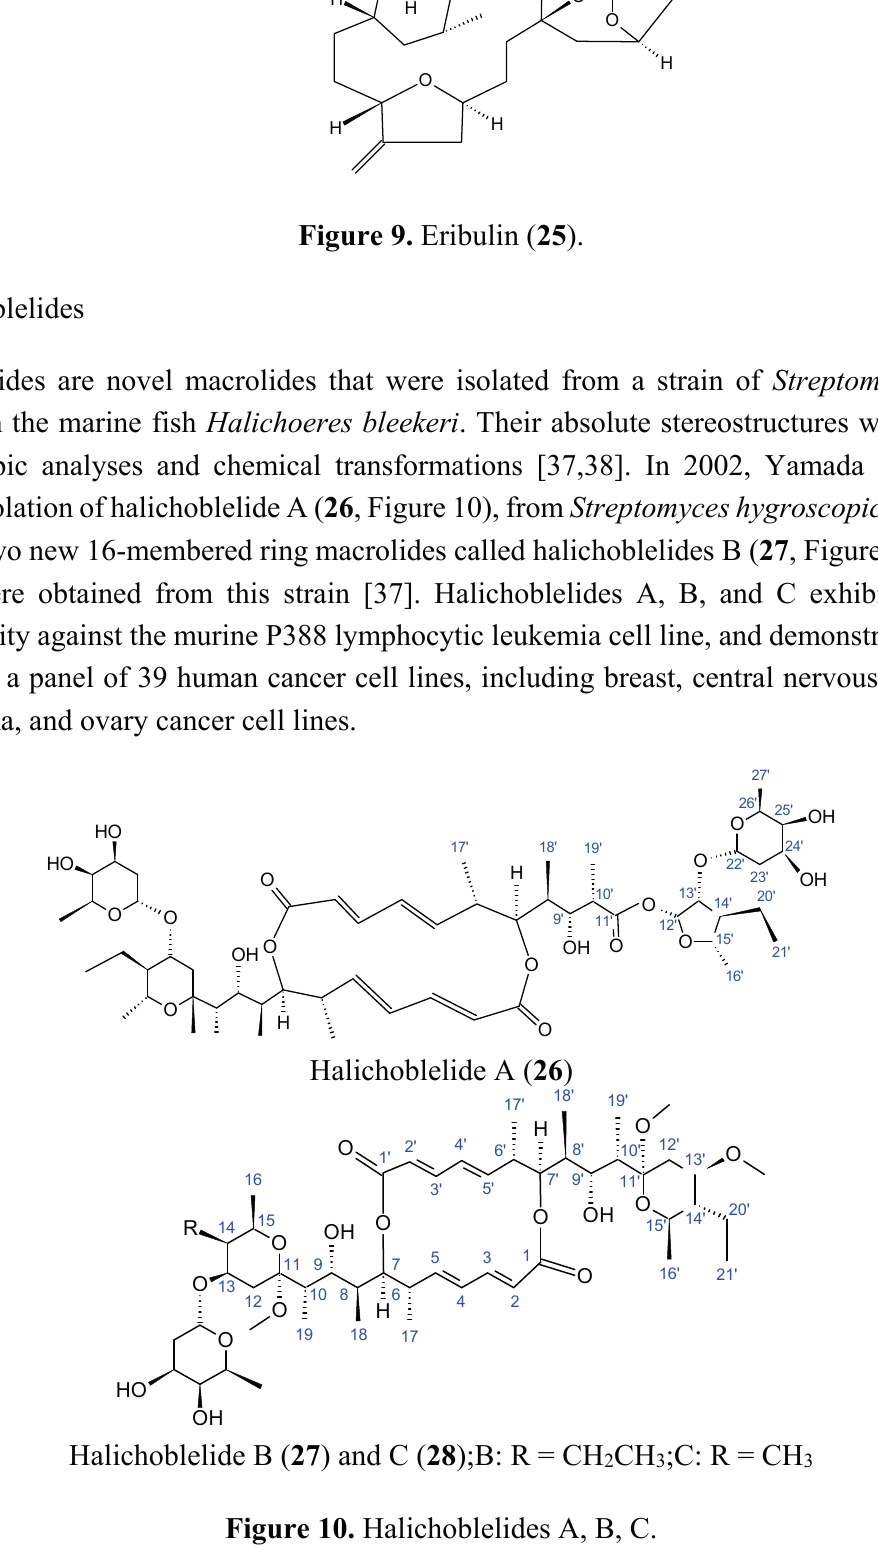
Figure 10. Halichoblelides A, B,